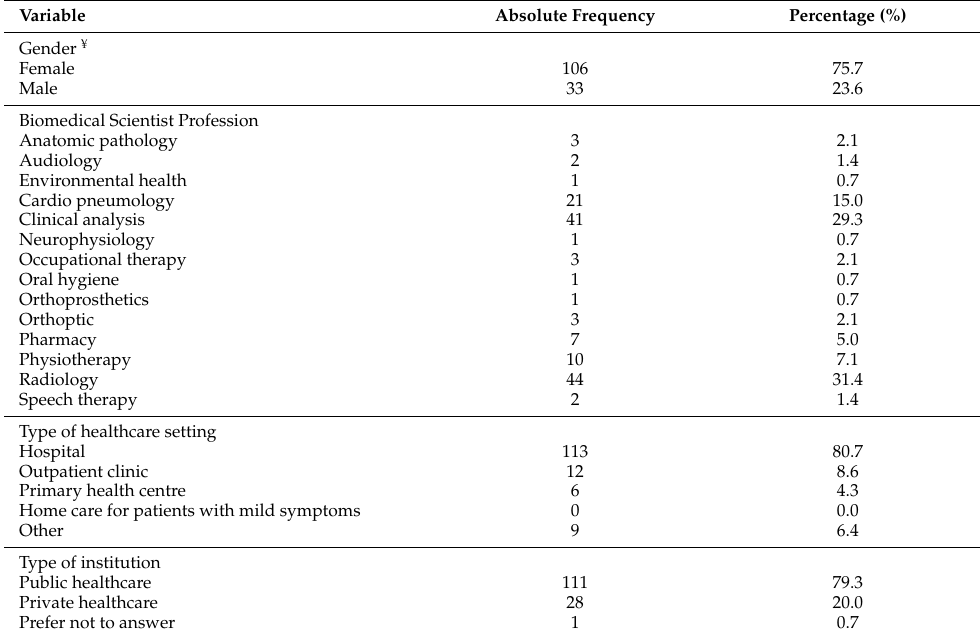
Table 1. Sociodemographic characteristics of biomedical scientists.